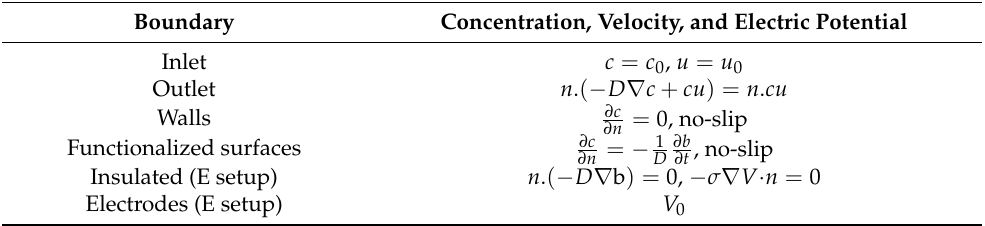
Table 4. Boundary conditions for four setups: original experimental setup (Case A), thin chamber (series H), suction (series S), and electroosmotic flow (series